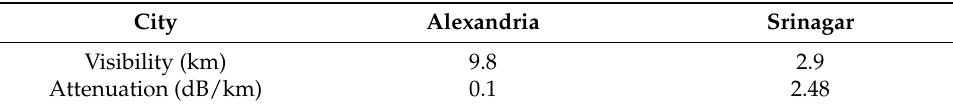
Table 4. Visibilities and attenuations of Alexandria and Srinagar